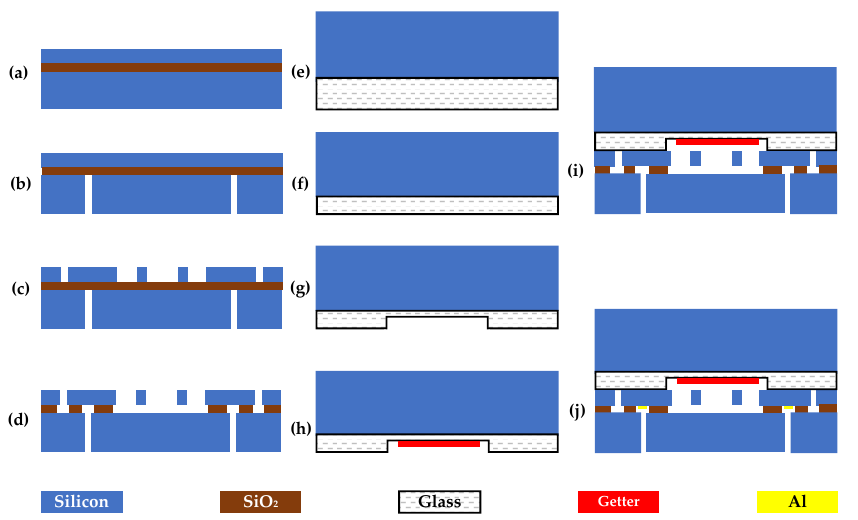
Figure 5. The fabrication processes of the sensor based on SOI-MEMS technologies. ( a ) Cleaning the SOI wafer; ( b ) conducting lithography to make through silicon vias on the handle layer; ( c ) conducting the second deep reactive ion etching (DRIE) on the device layer to form pressure-sensitive structures; ( d ) releasing resonant beams by HF; ( e ) conducting anodic bonding between a silicon wafer and a BF33 glass wafer; ( f ) thinning the glass layer of the SOG wafer by chemical mechanical planarization (CMP); ( g ) dry etching the glass wafer; ( h ) evaporating getters on the cavity; ( i ) conducting anodic bonding between the SOI and the SOG wafers; ( j ) evaporating aluminum electrodes for wire connections.